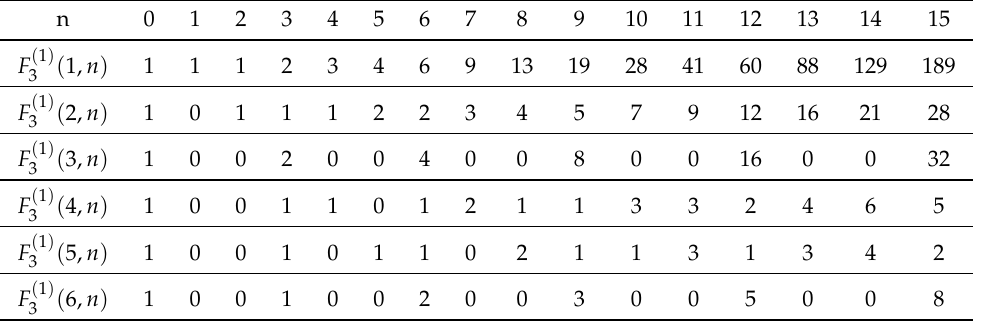
( 2 ) ( k , n ) for k ∈ { 1,2, . . . ,6 } 3